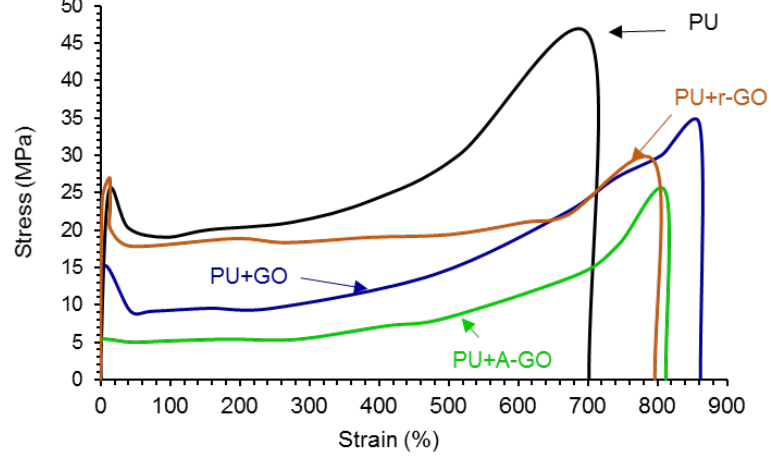
Figure 16. Stress-strain curves of the PUs.